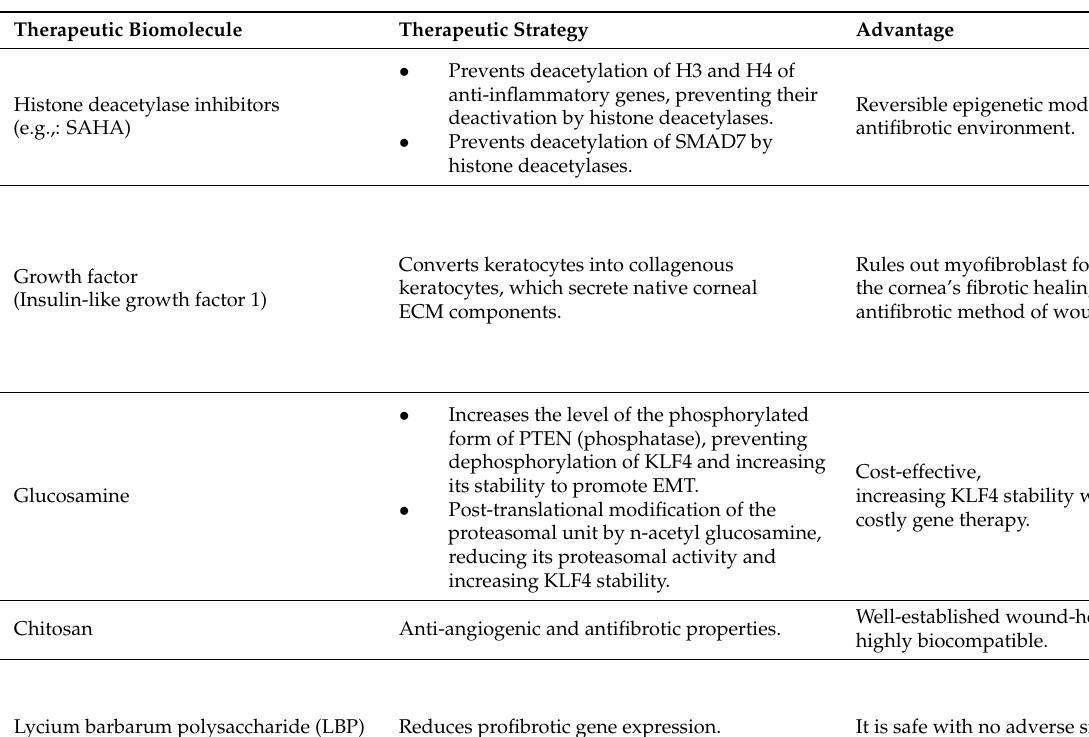
Table 4. Biomolecules as therapeutic tools in reviving a cornea without